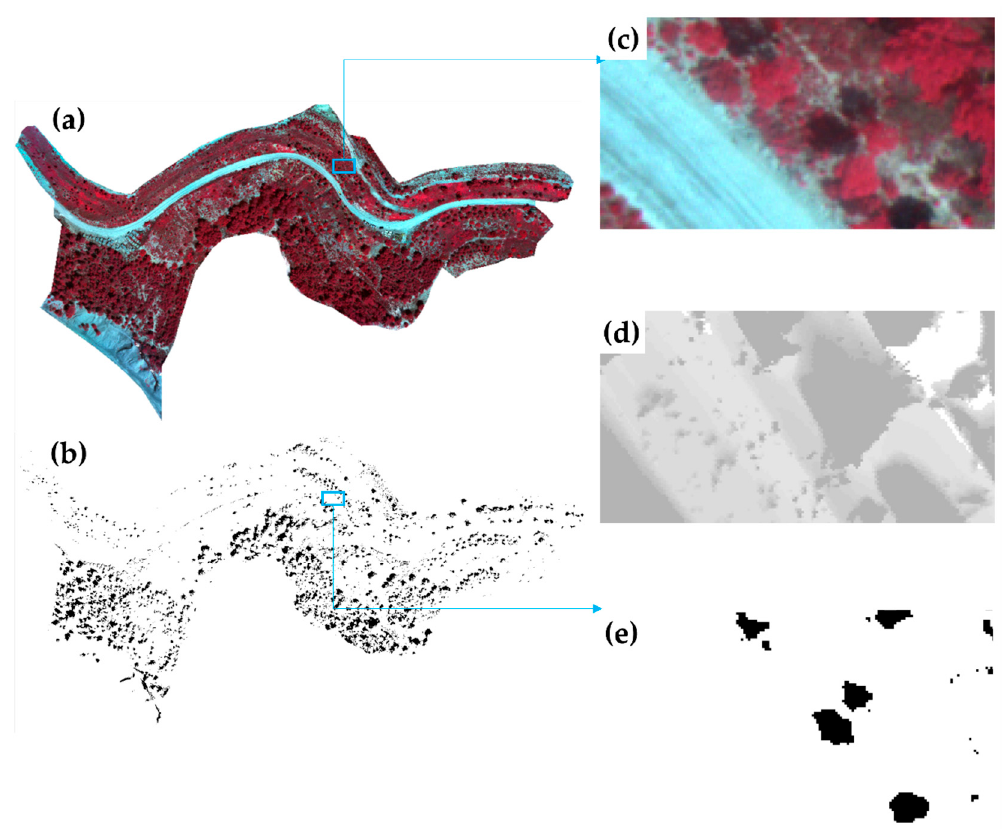
Figure 8. ( a ) Original orthoimage with shadows. ( b ) Shadow mask obtained after the shadow detection procedure. ( c ) Detail of some tree shadows. ( d ) Detail of the digital cast shadow model projection, based on a 2.5D digital surface model. ( e ) Detail of the constraint for selecting only dark pixels in the projected shadows that avoided false positives.